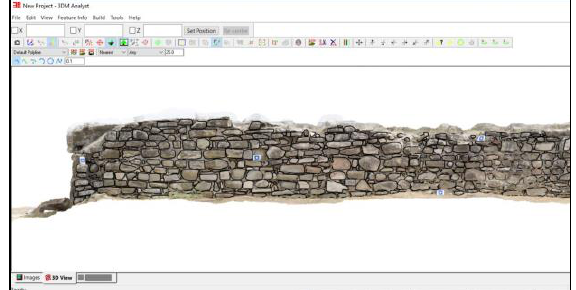
Figure 8. Completed Drawing of Wall Section in 3DM